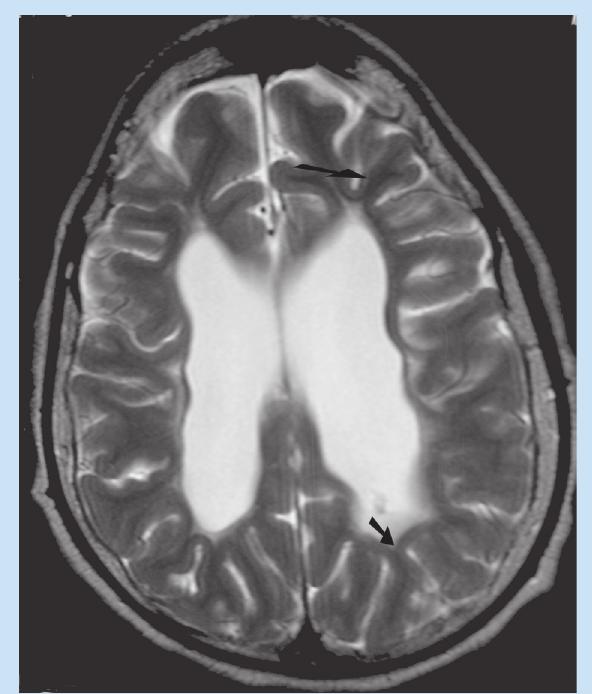
Fig. 2.1c. T2 demonstrating deep sulcus sign (short arrow) as a result of white matter volume loss. Ulegyria (long arrow) [mushroom-shaped gyri] is the consequence of hypoxia at the watershed zones.